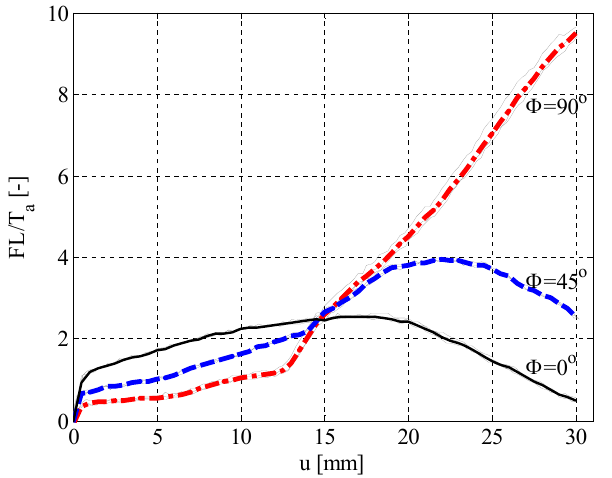
Figure 4a. Mean pull force F as a function of the displacement u of an object (Dobj=115 mm) in three different directions Φ (see also Fig. 2). F is normalized to the actuation torque Ta and the finger length L. The gray, thin lines represent the raw data. Table 1. Results of benchmark test 1, showing that in both object positions the smallest and largest available objects could be suc- cessfully grasped.